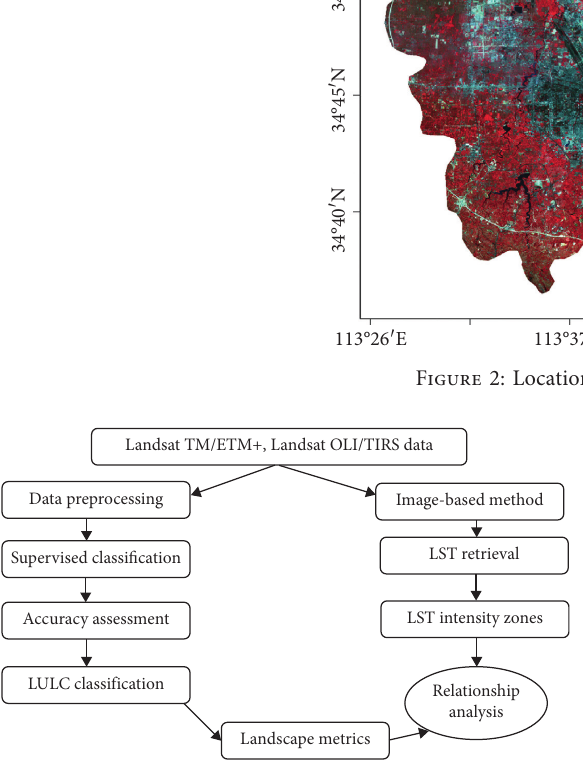
Figure 3: The flowchart of this study.